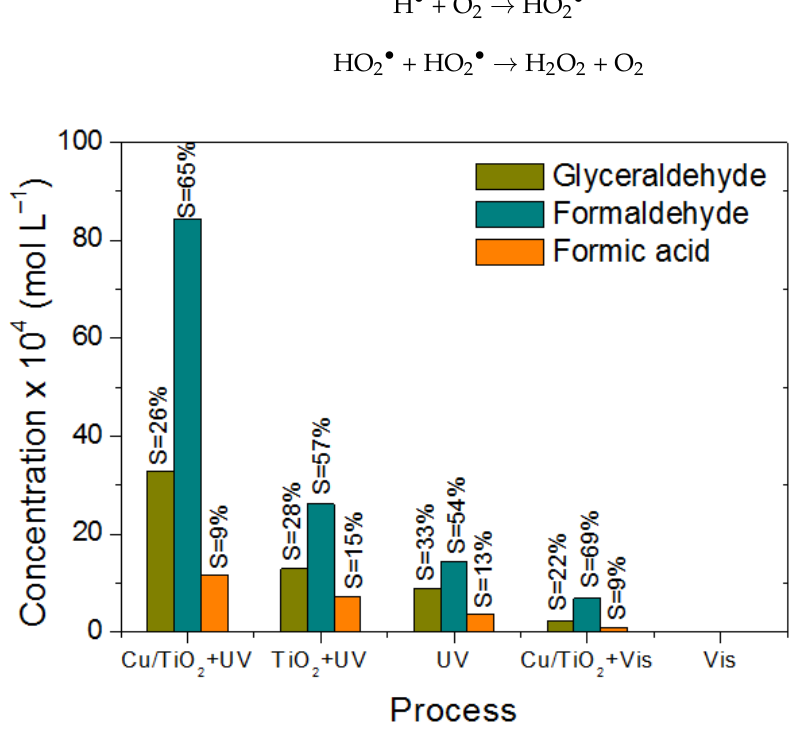
Figure 17. Comparison of the best reaction conditions using UV and visible light towards the con- centration and selectivity of products during the glycerol selective